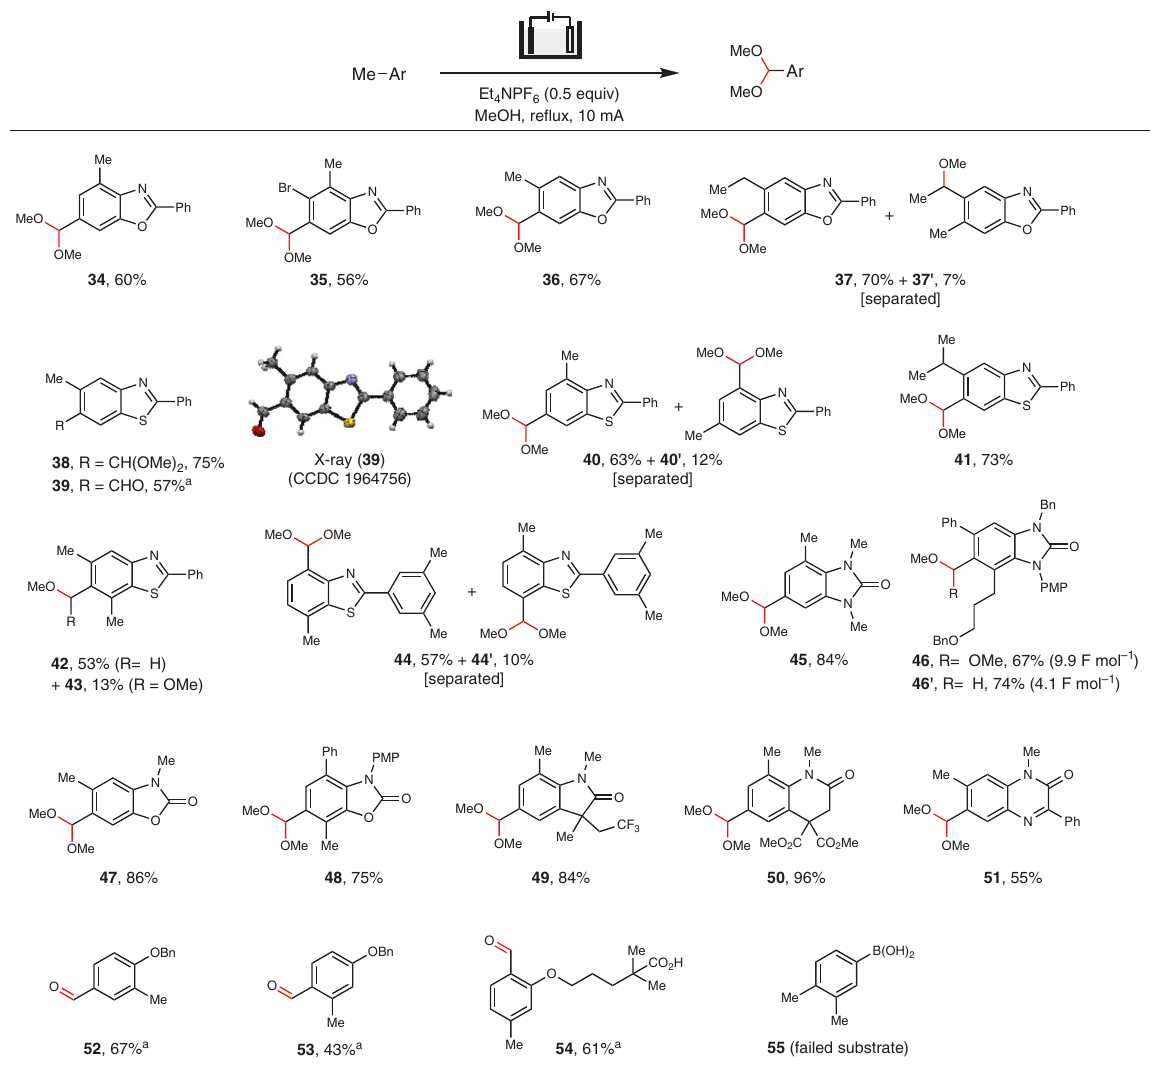
Fig. 3 Electrooxidation of various methyl benzoheterocycles. Reaction conditions: methylarene (0.2 mmol), MeOH (0.022 M), re fl ux, 2.2 – 5.3 h. All yields are isolated yields. Regioisomers were not observed unless otherwise mentioned. a Electrolysis was followed by hydrolysis with aqueous HCl (2